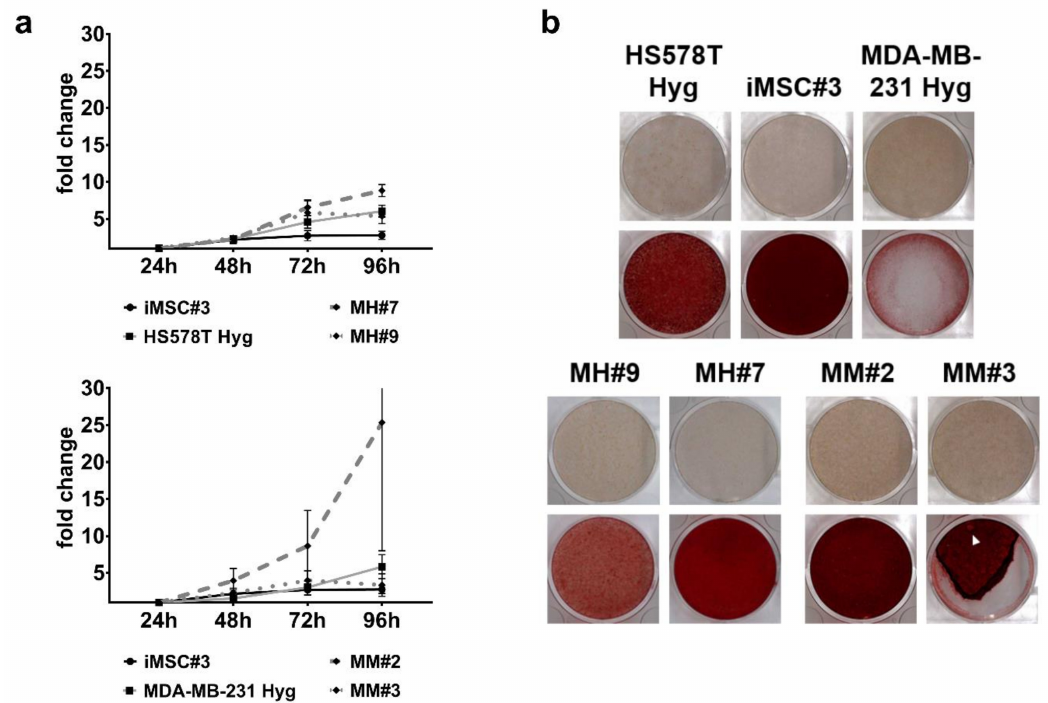
Figure 1. General characterization of MM and MH hybrid cells ( a ) The XTT-proliferation assay demonstrated that hybrid cells MM#2 and MH#7 exhibited a higher proliferation rate than both parental cell lines, while MM#3 and MH#9 showed an increased proliferation rate compared to iMSC#3 cells. The fold change was set to one for the data generated after 24 h. Shown are the means of at least three independent experiments. ( b ) All 4 hybrid cells were able to undergo osteogenic di ff erentiation, as well as iMSC#3 and HS578T Hyg parental cells. A white arrow marked the formation of a knob, which was found in MM#3